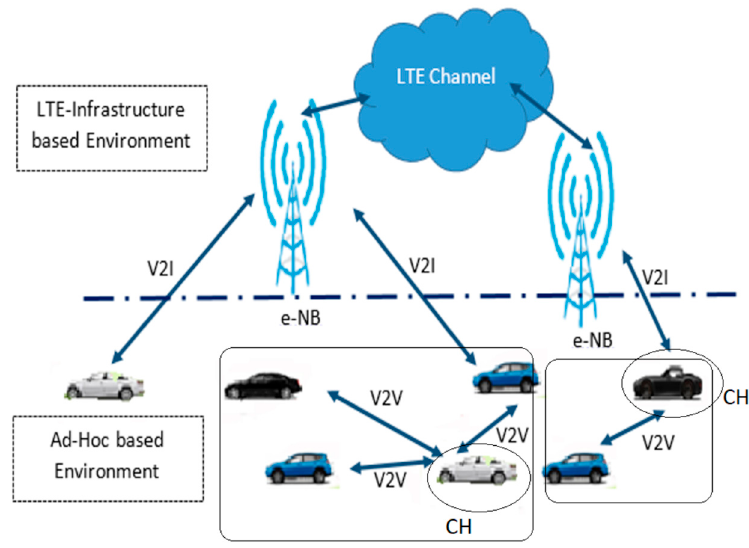
Figure 1. V2V benchmark for N moving vehicles based on LTE structure.